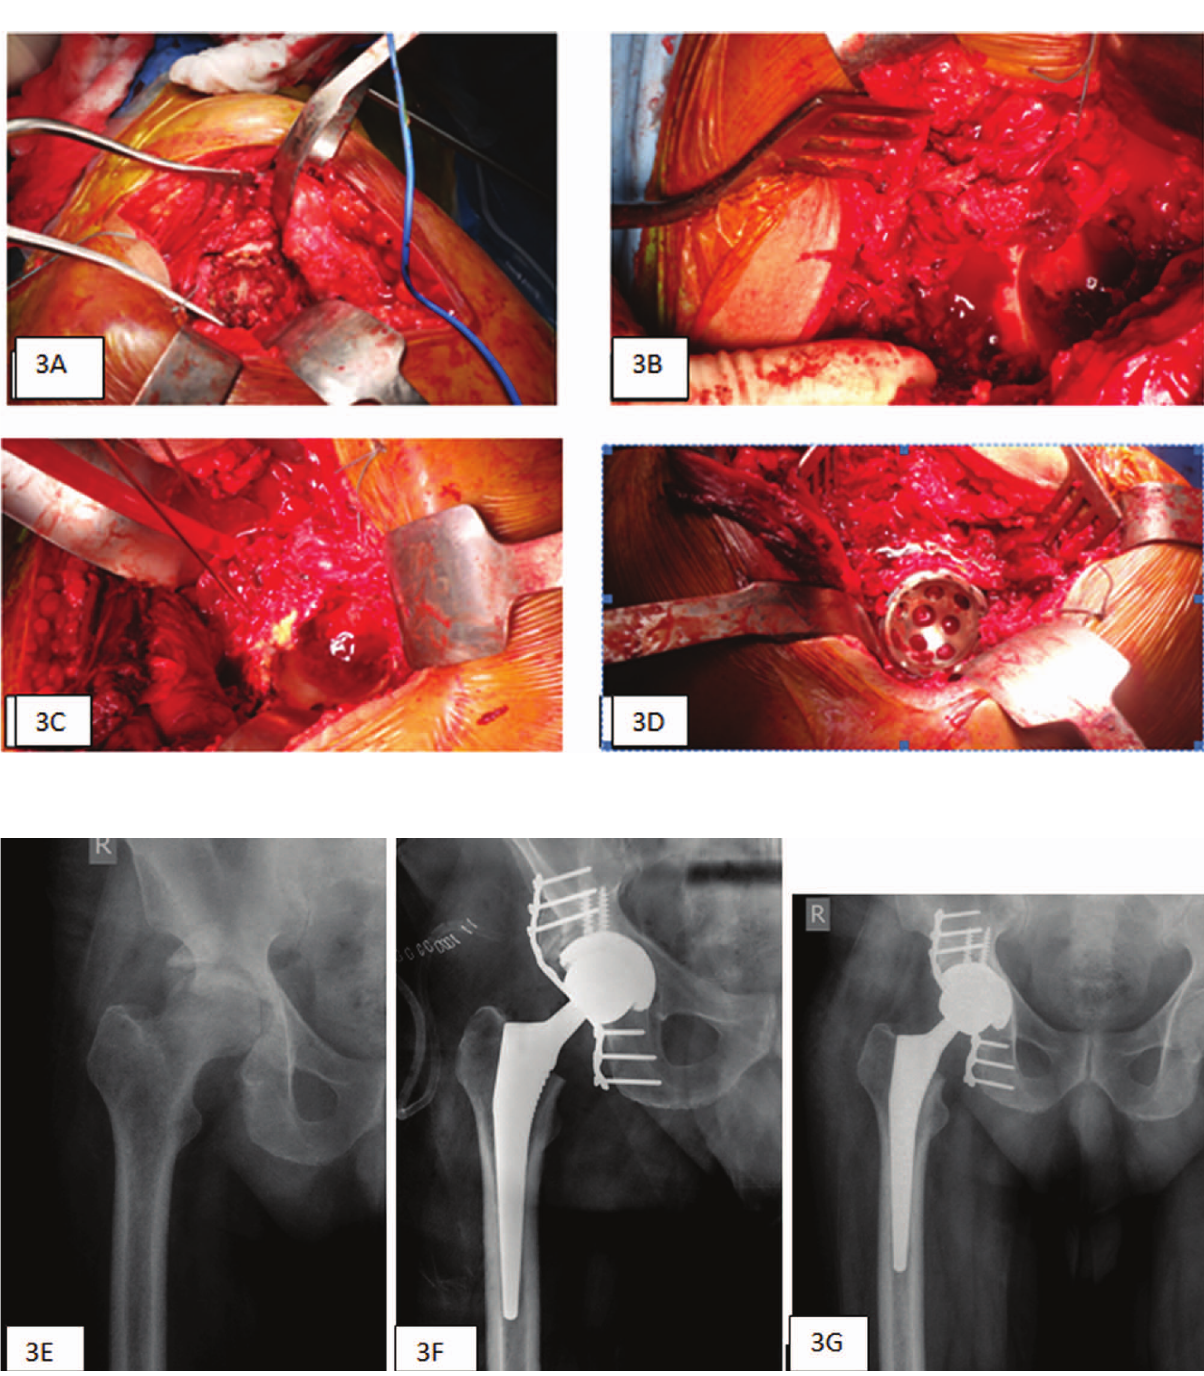
Figure 3. (A) 360 (cid:3) view of a neglected acetabular fracture and analysing the defect intra-operatively. (B) Posterior wall defect. (C) Provisional fi xation of the defect with K-wires. (D) Final fi xation with plate and cup. (E) Radiograph showing a posterosuperior wall acetabulum fracture. (F) Immediate post-operative radiograph showing fracture reduction and fi xation with a plate. (G) Radiograph at 5-years